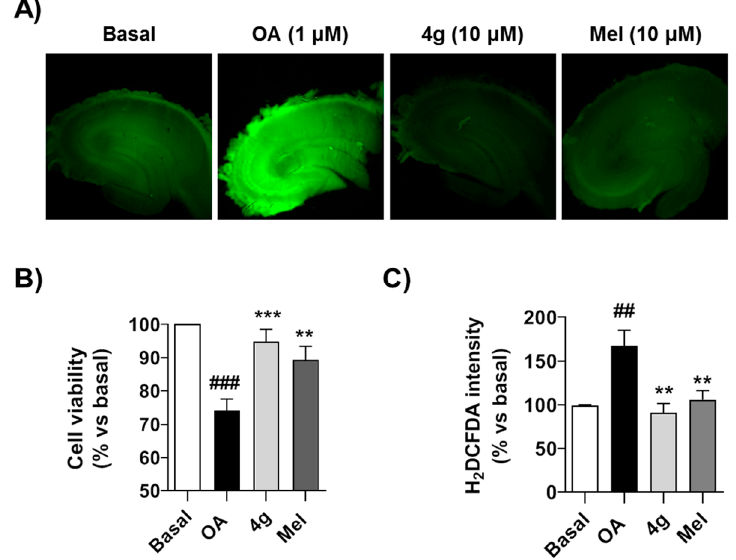
Figure 4. Compound 4g protects against acute toxicity induced by OA in hippocampal slices: ( A ) Representative H 2 DCFDA fluorescence images of hippocampal slices treated with OA in presence or absence of 4g (10 µ M) or melatonin (10 µ M) during 6 h. ( B ) Cell viability of hippocampal slices treated with saline (Basal), OA (1 µ M), OA (1 µ M) + 4g (10 µ M) or OA (1 µ M) + melatonin ( Mel , 10 µ M) during 6 h. Cell viability was then evaluated by MTT reduction assay and normalized to basal conditions (100%). ( C ) Quantitation of H 2 DCFDA fluorescence intensity as free radical production measurement after the experimental conditions described in ( B ). Data are expressed as mean ± S.E.M of four di ff erent experiments. ## p < 0.01, ### p < 0.001 compared to basal condition; ** p < 0.01, *** p < 0.001, compared to OA treated hippocampal slices.